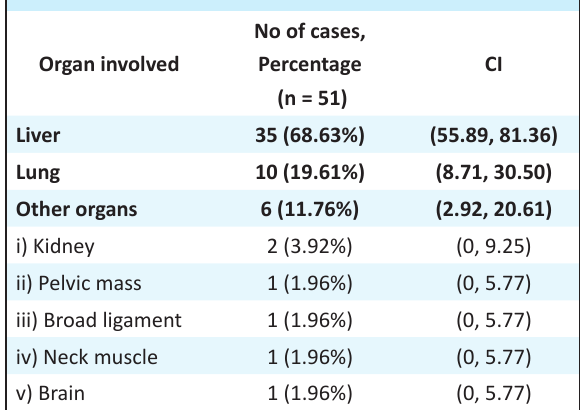
Table 3. Distribution of cases according to